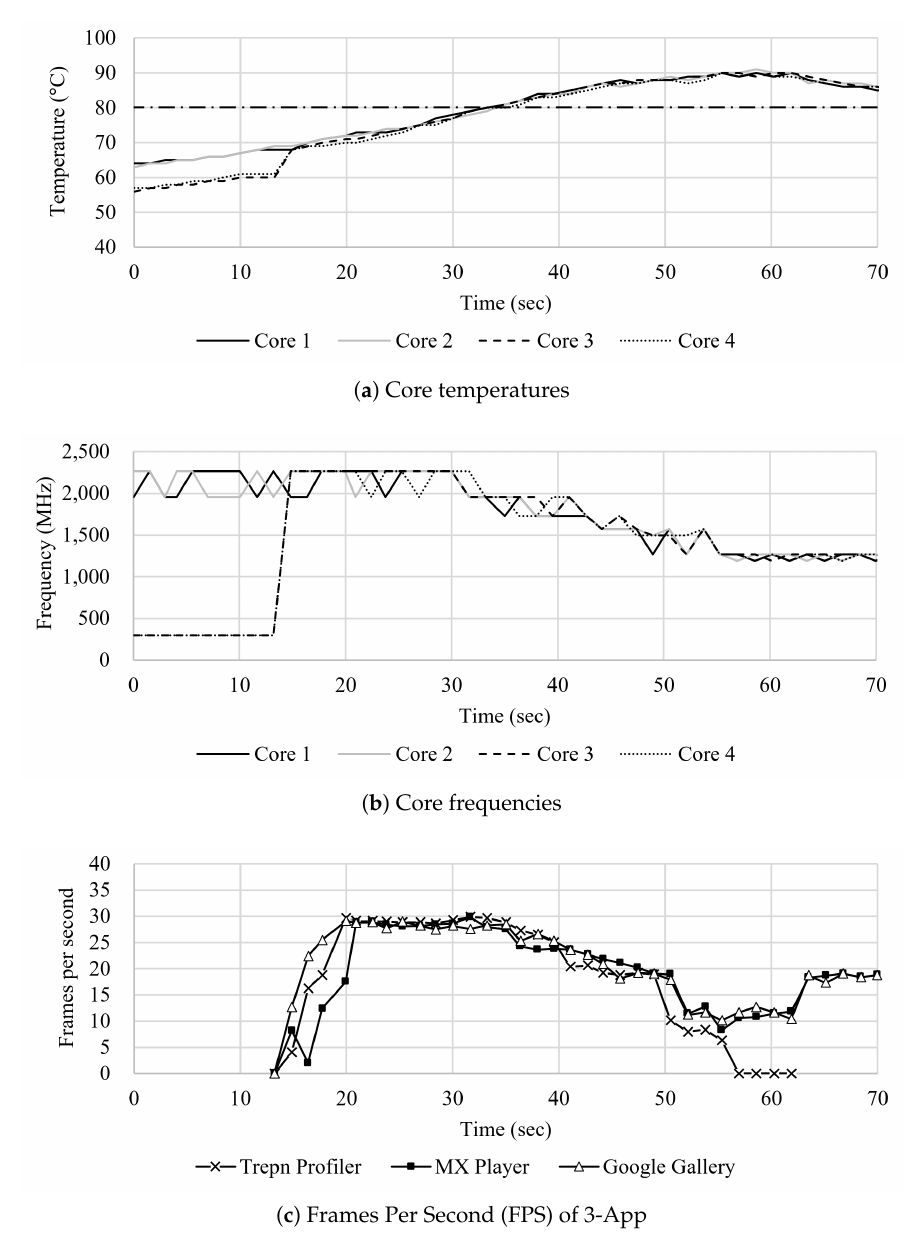
Figure 3. Analysis of service termination on 3-App scenario of NANS (N-App N-Screen)